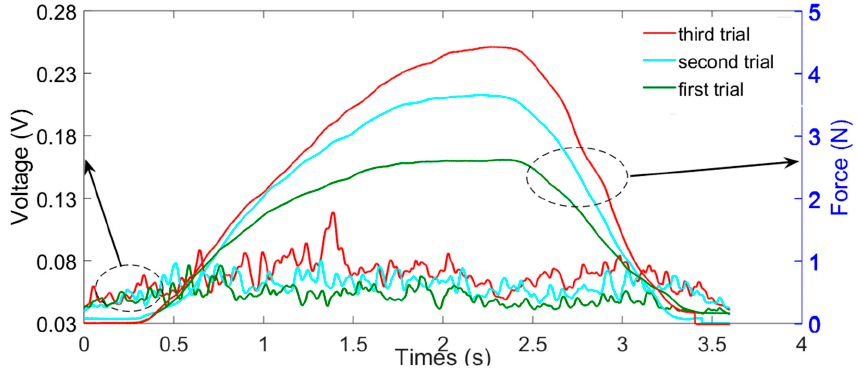
Figure 9. sEMG signals from biceps for three trials.